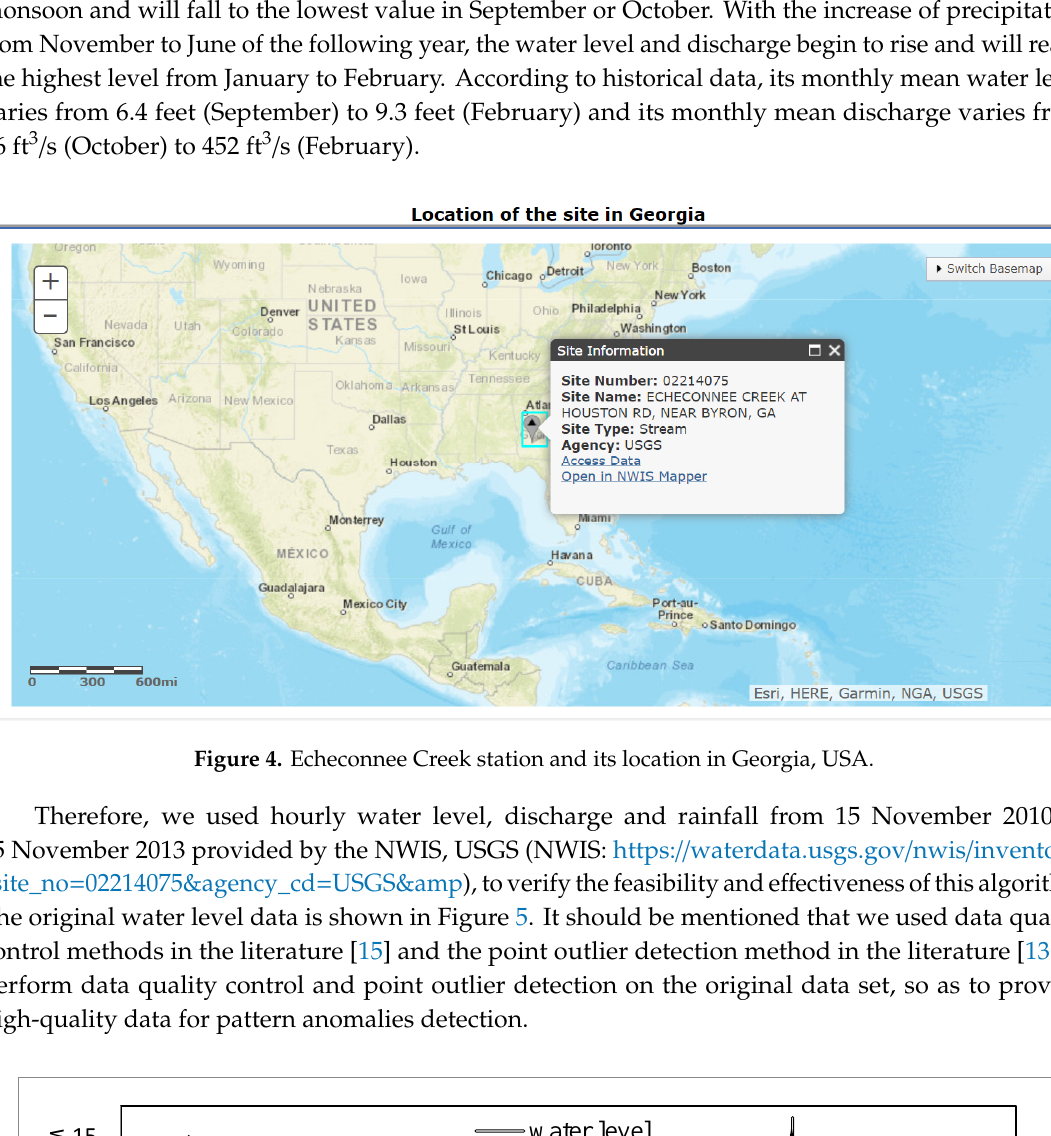
Figure 4. Echeconnee Creek station and its location in Georgia, USA.